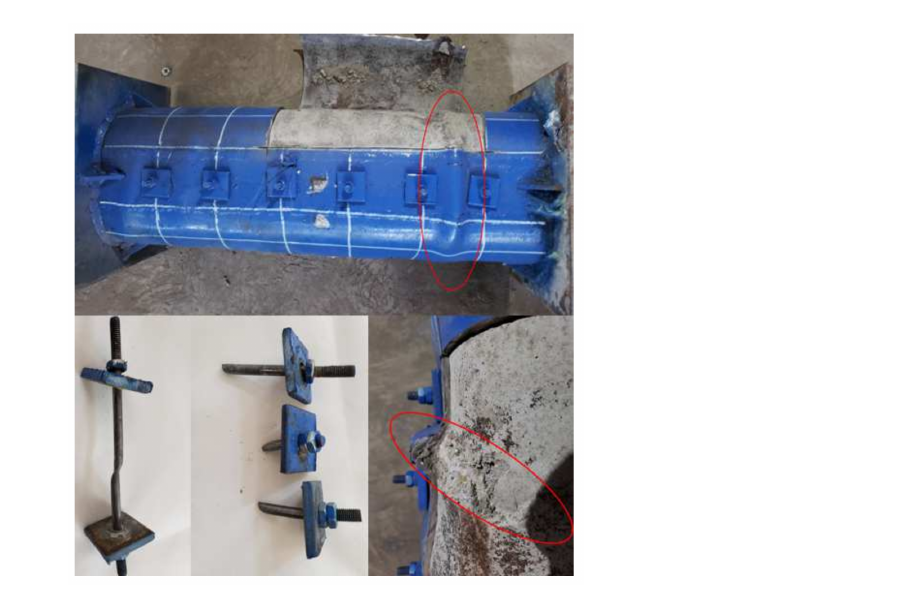
Figure 7. Typical failure modes of concrete and tie bar.